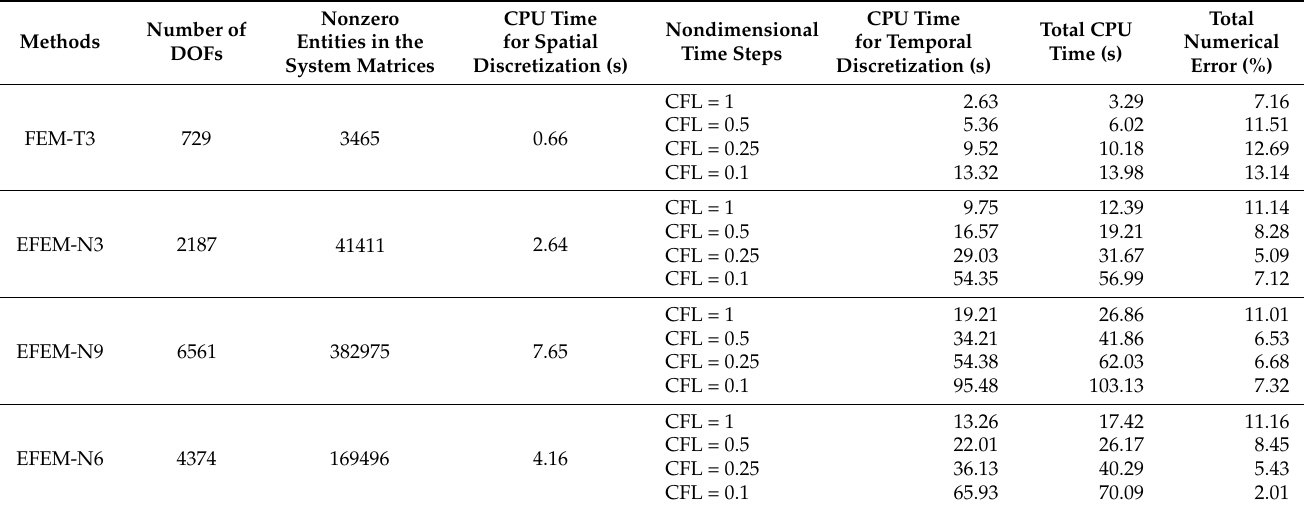
Table 1. Comparisons of the computational cost and computational efficiency of the different numeri- cal approaches in solving the scalar wave propagation in a clamped-free elastic bar.